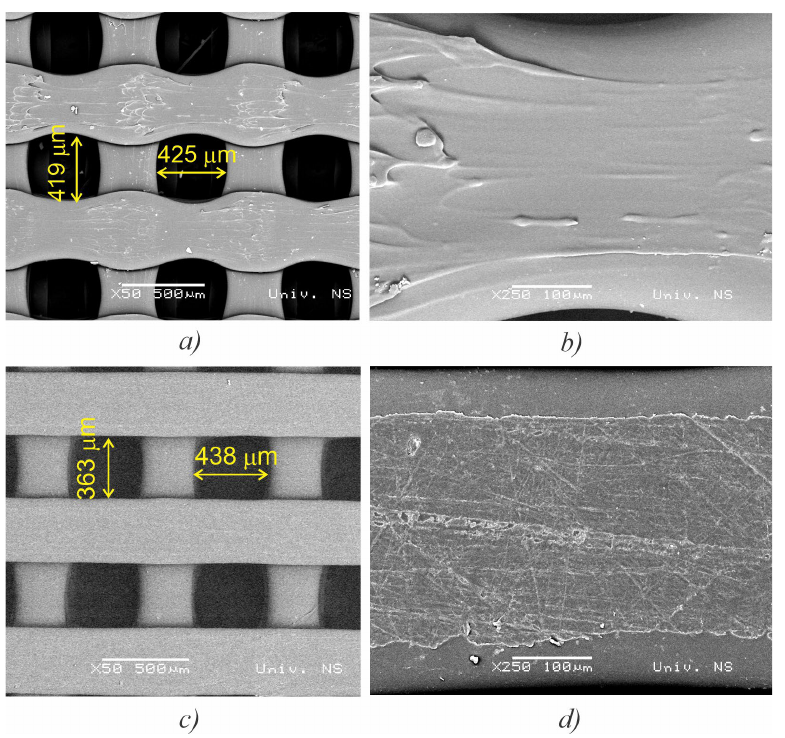
Figure 4. SEM micrographs showing grid morphology, pore size, and surface topography for the LLC ( a , b ), and HLC scaffolds ( c , d ).